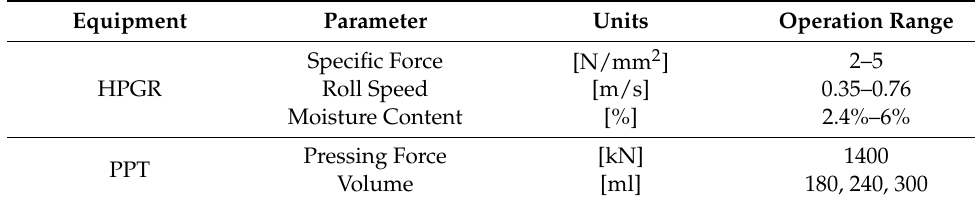
Table 2. Summary of operation parameters.